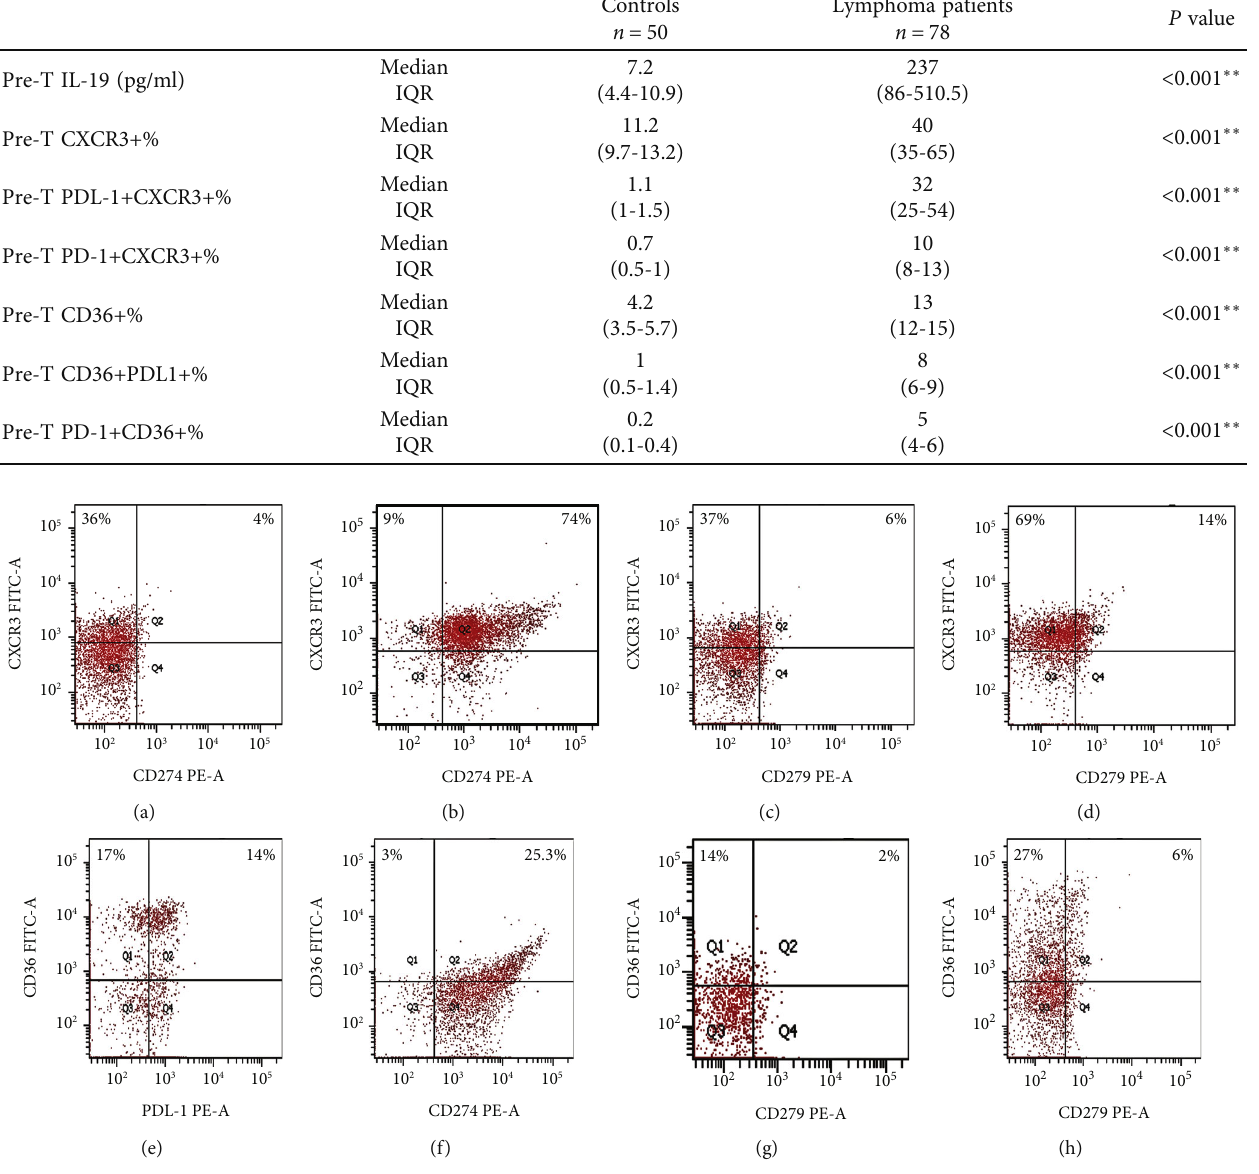
Figure 1: PD-L1/PD-1 is coexpressed with CXCR3/CD36 on peripheral lymphocytes in extranodal involvement. (a, b) Dot plots of PD-L1 +CXCR3+% from a lymphoma patient without and with extranodal involvement. (c, d) Dot plots of PD-1+CXCR3+% from a lymphoma patient without and with extranodal involvement. (e, f) Dot plots of PD-L1+CD36+% from a lymphoma patient without and with extranodal involvement. (g, h) Dot plots of PD-1+CD36+% from a lymphoma patient without and with extranodal involvement. The percentages of positive cells are shown in the upper right